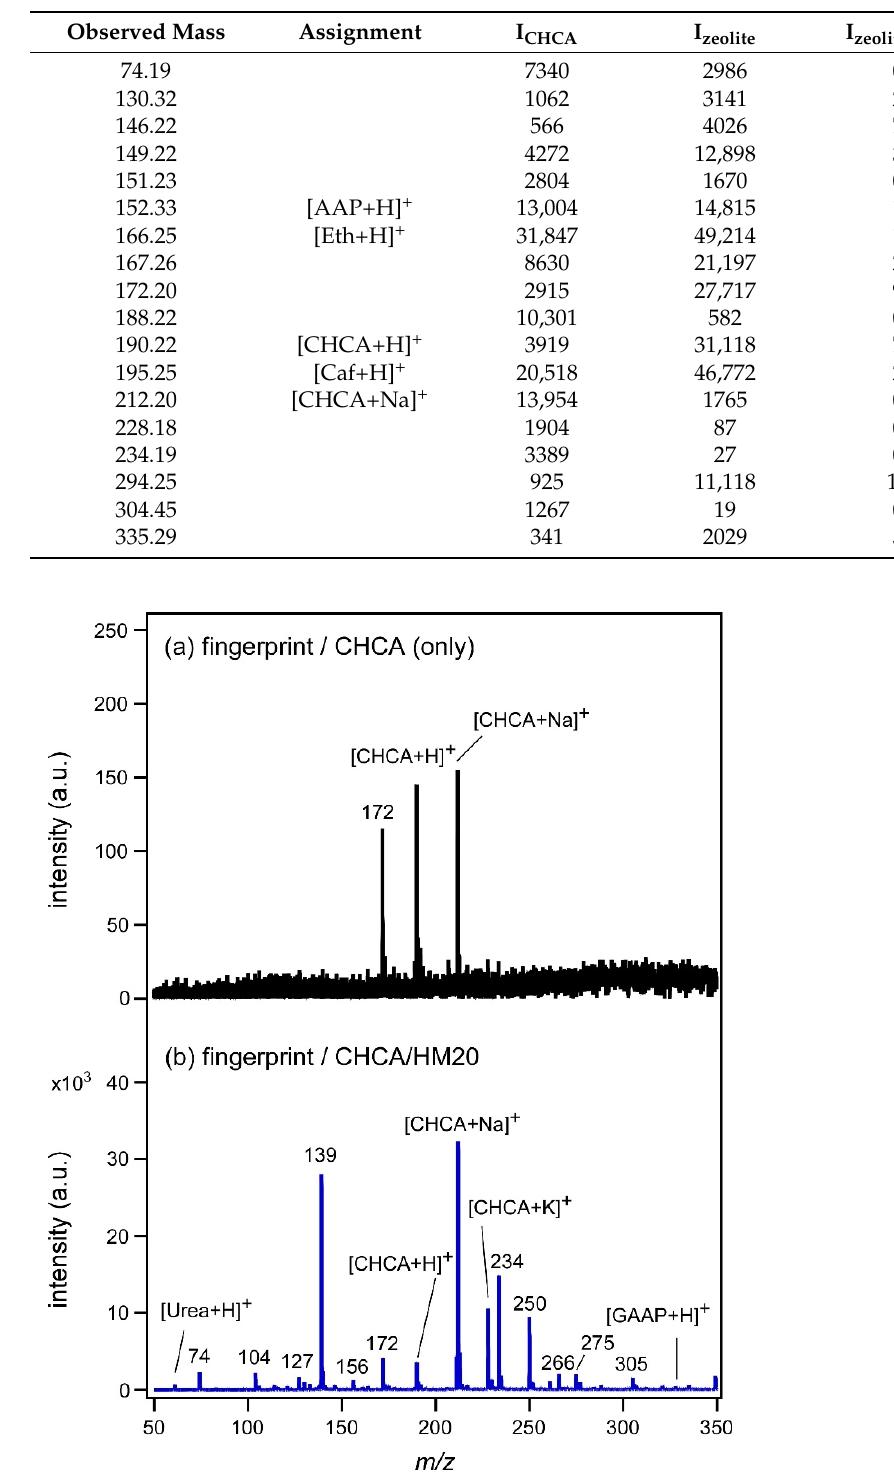
Table 1. m / z value, assignment, and intensity for each peak observed in Figure 1.